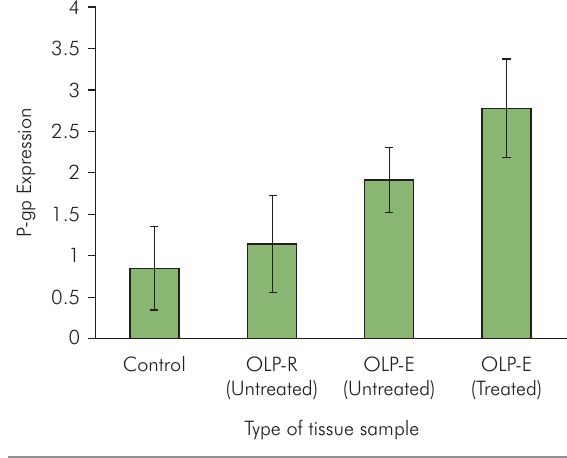
Figure 3. ELISA results show that expression of p-glycoprotein (P-gp) is higher (p < 0.0001) in all OLP groups compared to the control group. Significant overexpression of P-gp (p < 0.05) was observed in the untreated erosive group compared to reticular group. The corticosteroid-treated erosive group shows significantly higher (p < 0.03) expression of P-gp compared to untreated erosive group. (OLP-R: Oral lichen planus reticular type; OLP-E: Oral lichen planus erosive type; OLP-ET: Oral lichen planus erosive